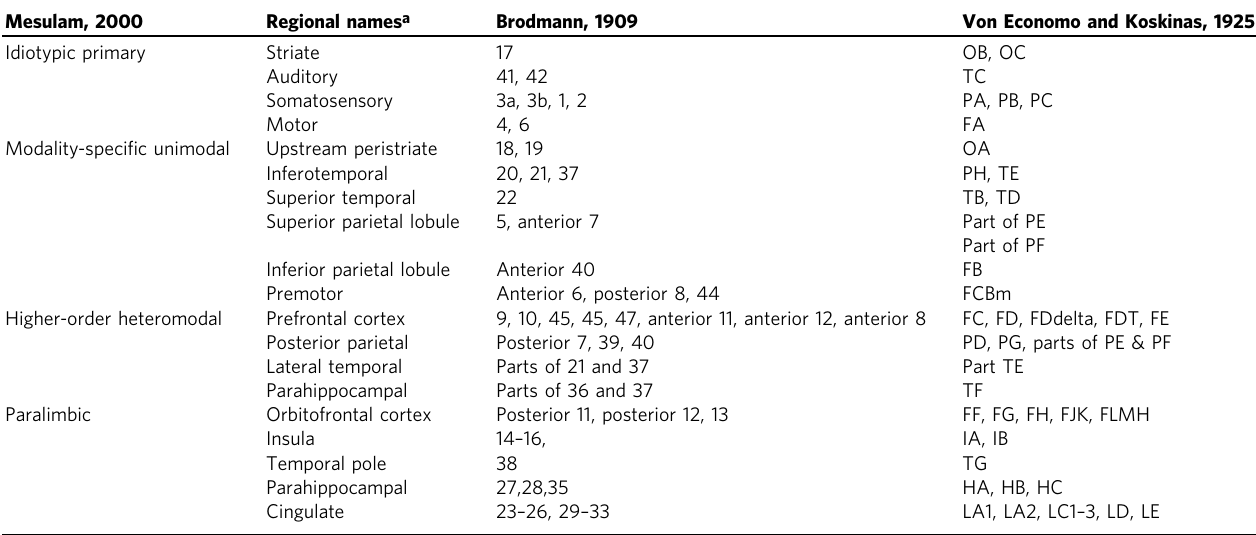
Table 1 Replication of table in Paquola, 2019 of Mesulam classes